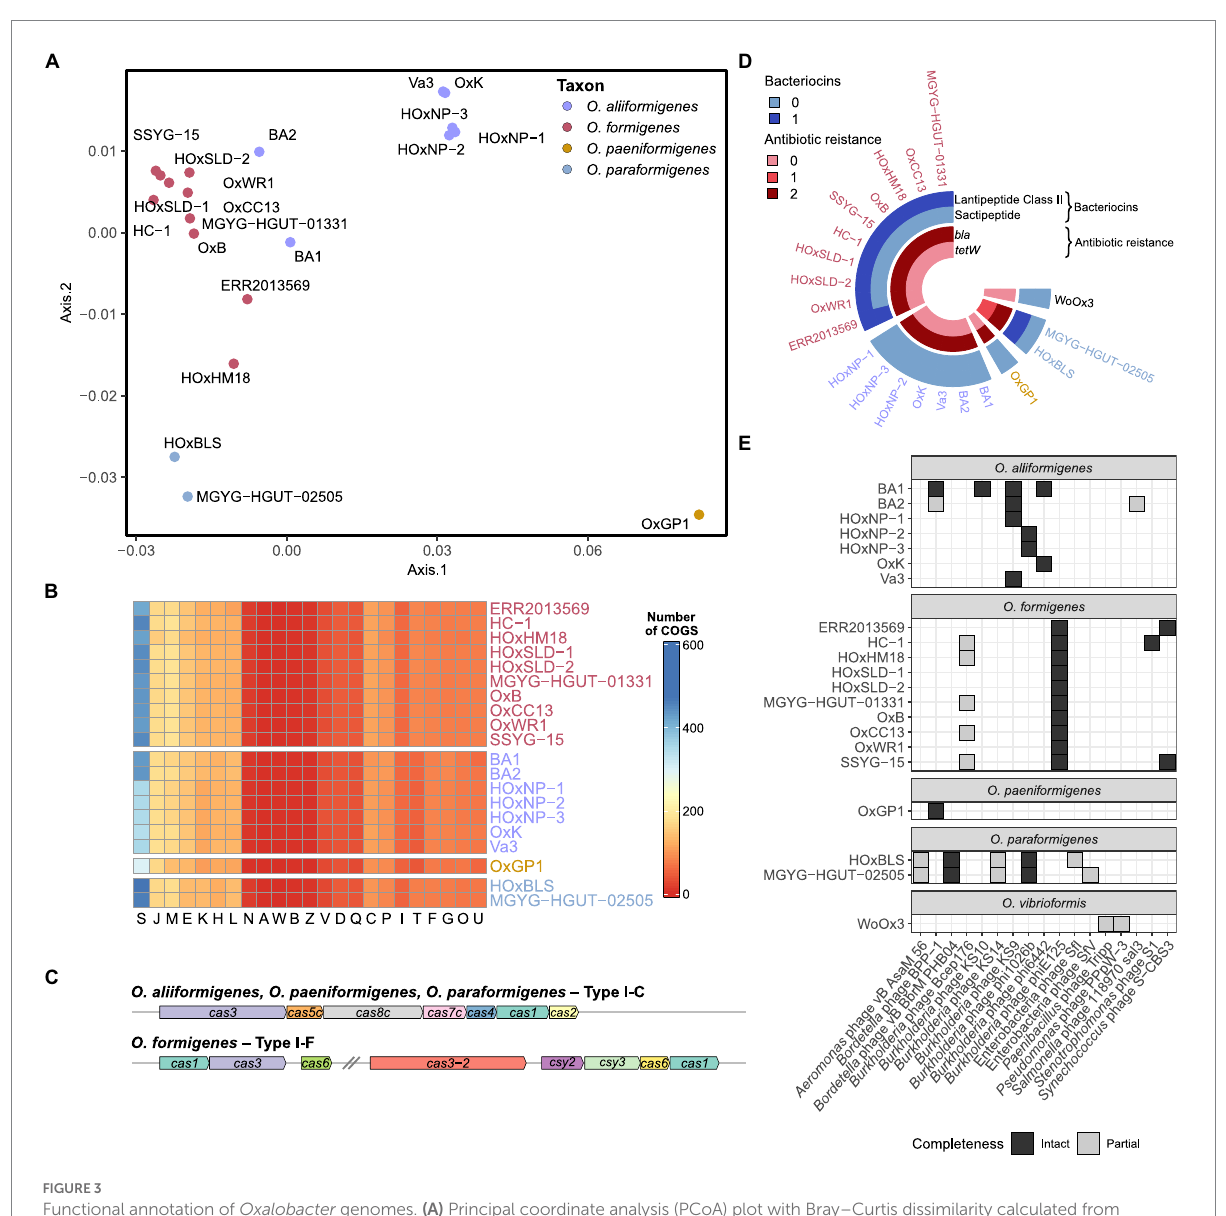
FIGURE 3 Functional annotation of Oxalobacter genomes. (A) Principal coordinate analysis (PCoA) plot with Bray–Curtis dissimilarity calculated from absolute abundance of cluster of orthologous group (COG) categories. (B) Heatmap displaying that absolute abundance of each COG category. (C) Gene arrow maps of Cas clusters found in Oxalobacter species. Note cas8c gene was not identified in O. aliiformigenes OxK and the trailing cas1 gene was not identified in O. formigenes HOxHM18. (D) Circular heatmap showing the abundance of bacteriocins and antibiotic resistance genes found in the analyzed Oxalobacter genomes . (E) Heatmap showing the presence and completeness of prophages found in the analyzed Oxalobacter